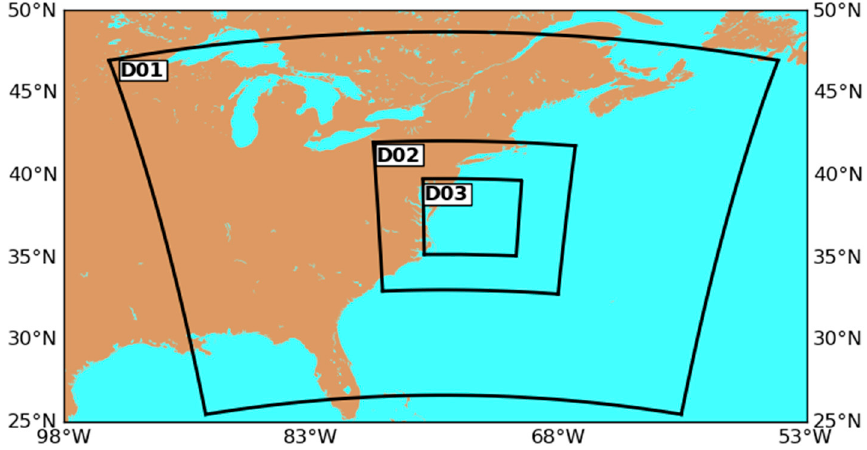
Figure 2. The three domains used for the WRF model simulations.